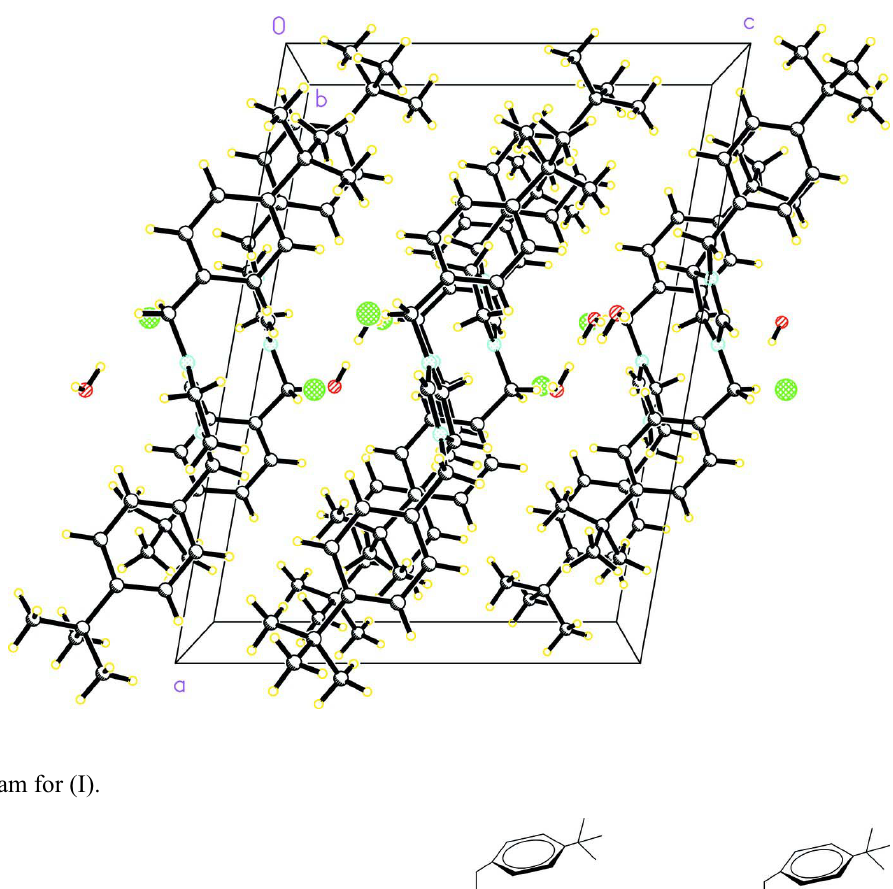
Figure 3 The formation of the title